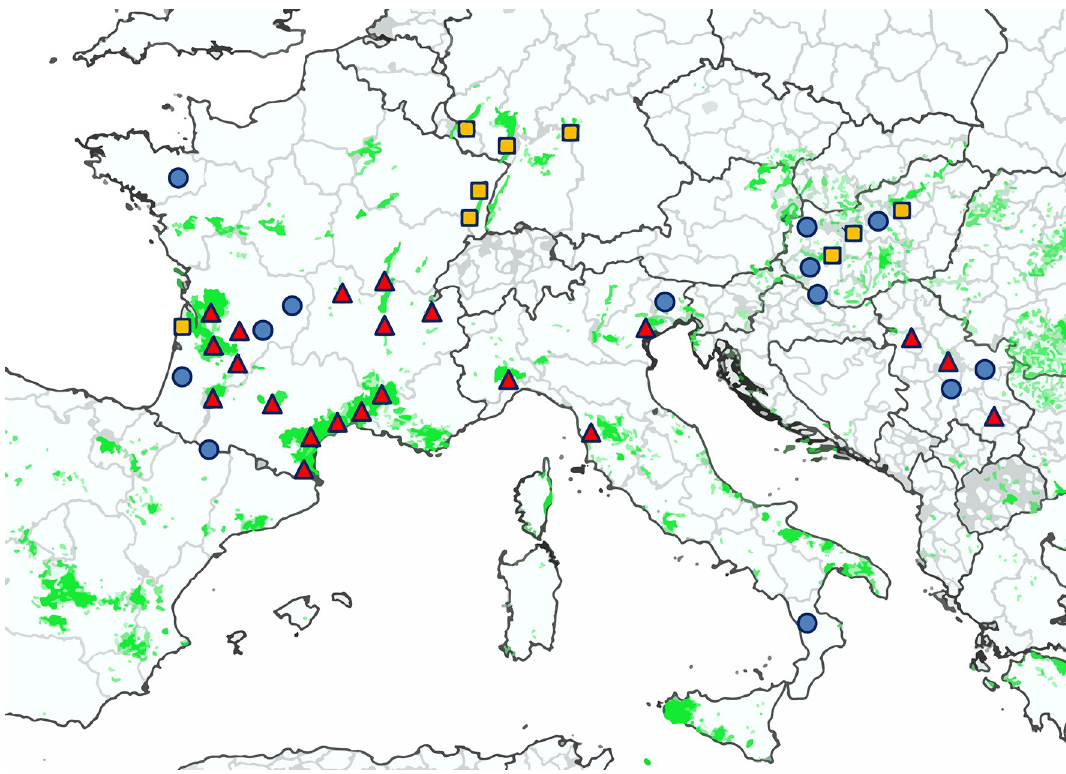
Fig 1. Location of samplings. Vineyards areas are appearing in green according to Corine Land Cover database CLC2012 release of the European Copernicus public program (https://www.copernicus.eu/en). Sampling sites were in non viticultural area (blue dots), in FD-free vineyards (yellow squares) and in FD-infected vineyards (red triangles) at the time of sampling. A detailed description of the sampled localities and the plant and insect sampled are given in Table 1 and S1 Table.